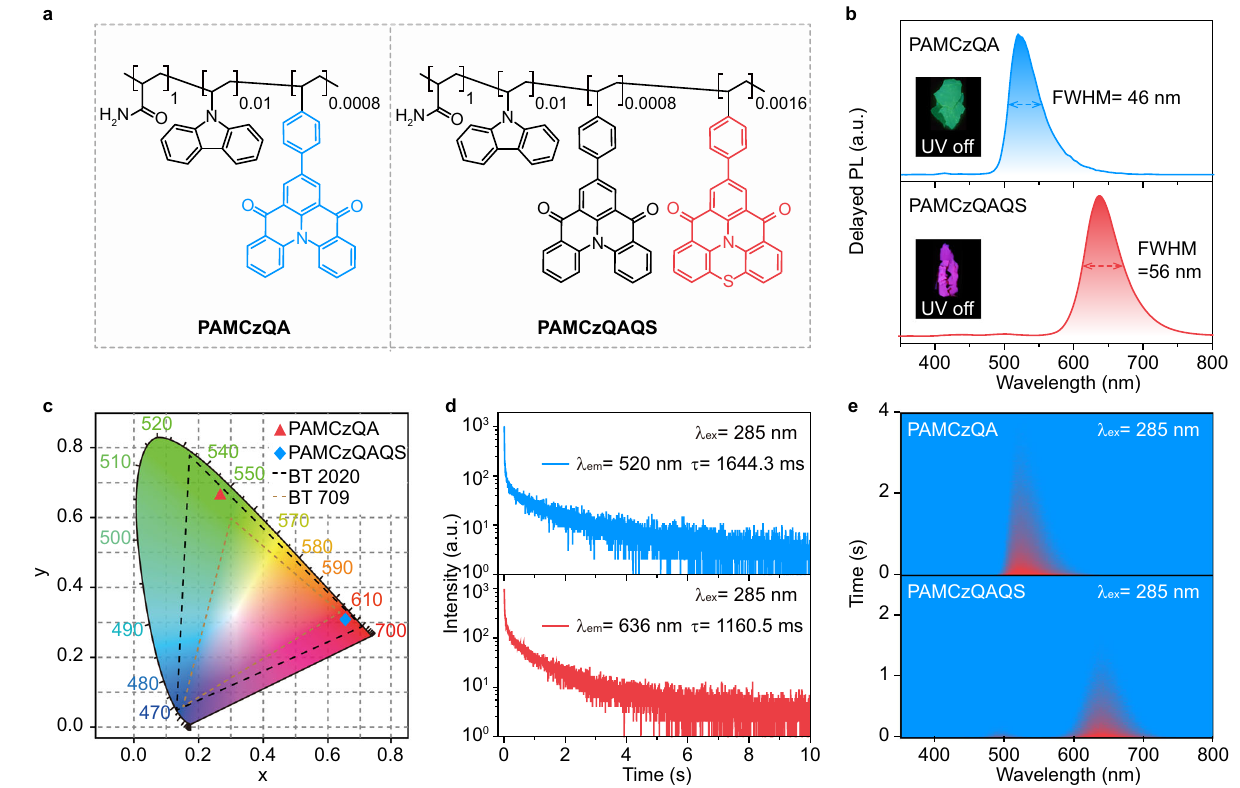
Fig. 4 | Mechanism and feasibility con fi rmation of hyperafterglow emission. a Moleculestructures of PAMCzQAand PAMCzQAQS. b DelayedPLspectra(10ms delay) of PAMCzQA (top panel) and PAMCzQAQS (bottom panel) fi lms. Inset: photographsofPAMCzQA(toppanel)andPAMCzQAQS(bottompanel) fi lmstaken